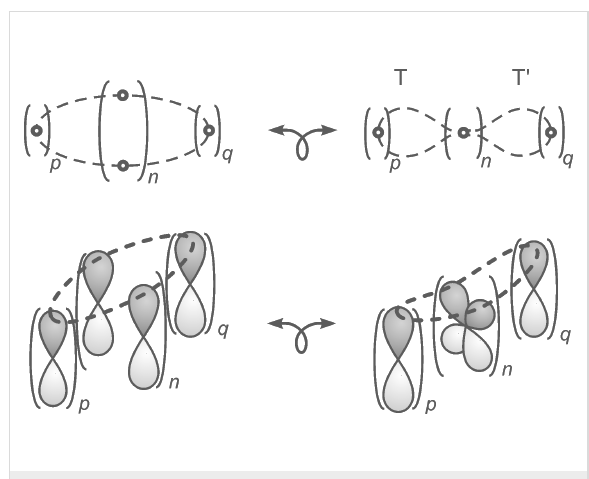
Figure 1: Formal, topological approach to derive coarctate reactions from pericyclic reactions; p , q : number of atoms or basis orbitals in the terminator groups T and T’; n : number of orthogonal pairs of basis orbitals in the transition state of coarctate reactions.